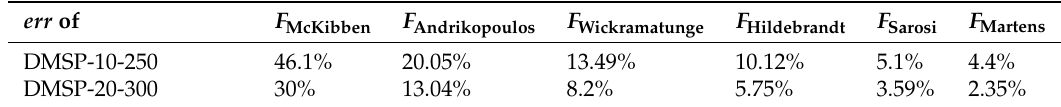
Table 3. Force error of each model by